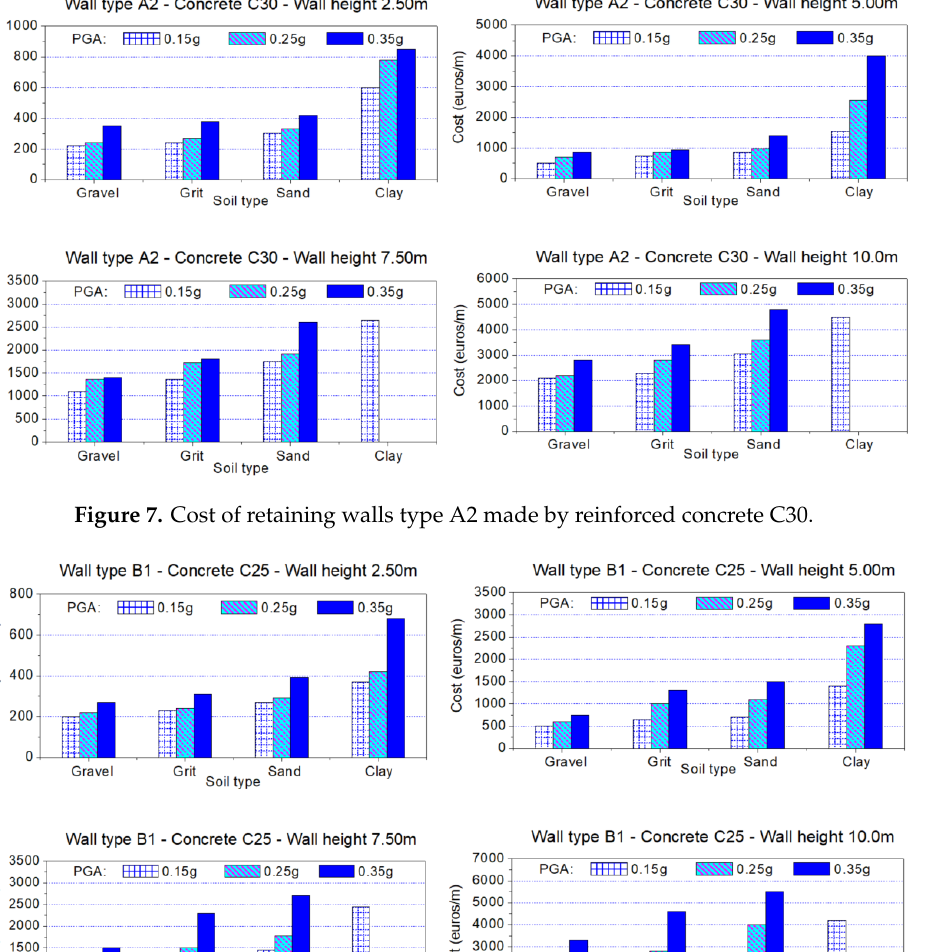
Figure 6. Cost of retaining walls type A2 made by reinforced concrete C25.